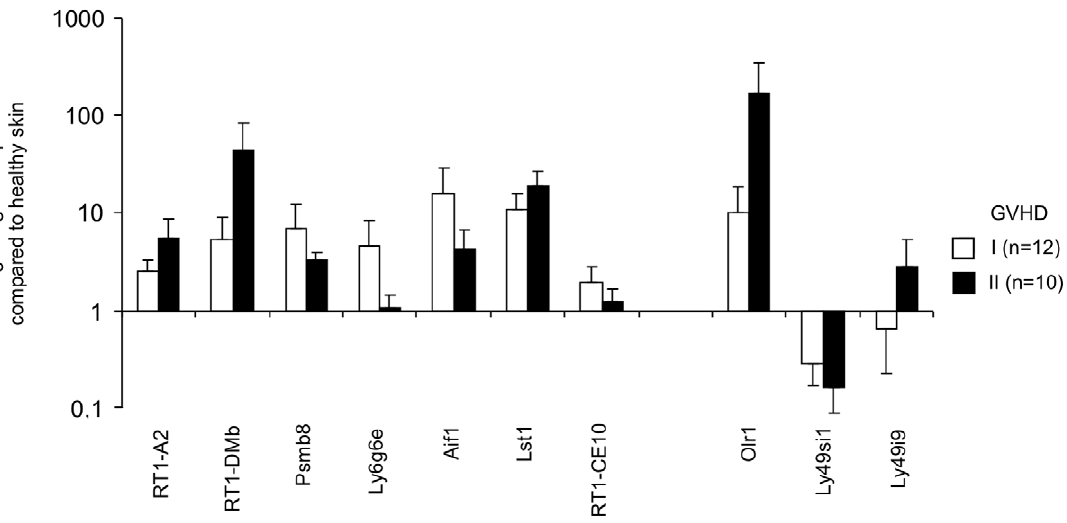
Figure 8. Analysis of MHC and NKC gene regulation in GVHD skin lesions from transplanted animals. BN ( RT1 n ) rats were transplanted with bone marrow of PVG ( RT1 c ) rats. Rats that developed acute GVHD were scarified and skin lesions with signs of GVHD were obtained for RNA preparation and histology. The expression of 7 MHC and 3 NKC was analyzed by qRT-PCR using the B2m gene as reference. The relative changes of gene expression levels were calculated [24]. The means plus SEM are shown for skin lesion with grade I and grade II GVHD. A value . 1 indicates an up-regulation of gene expression in the allogeneic samples. The control samples were freshly frozen skin samples from healthy BN rats (n=7).